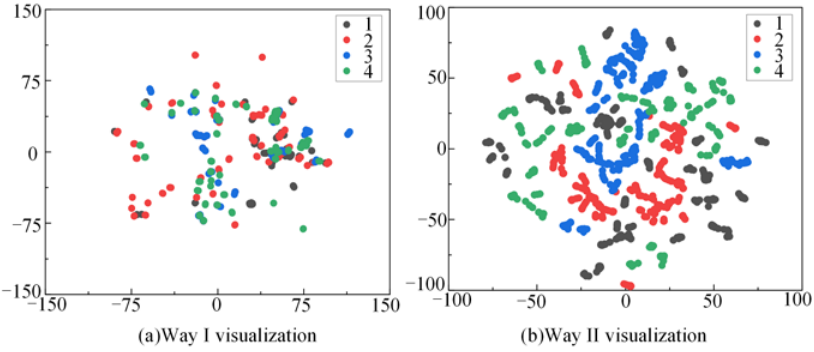
Figure 12. Different ways to visualize.